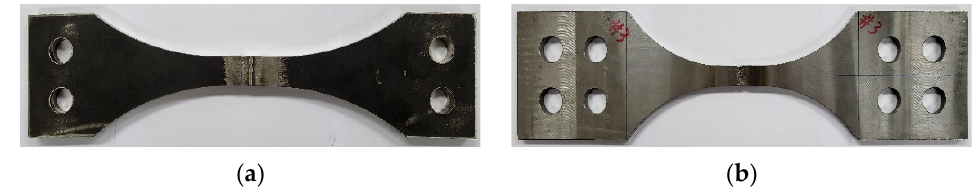
Figure 11. Fatigue test specimens for the weld metals: ( a ) high Mn; ( b ) 9% Ni.